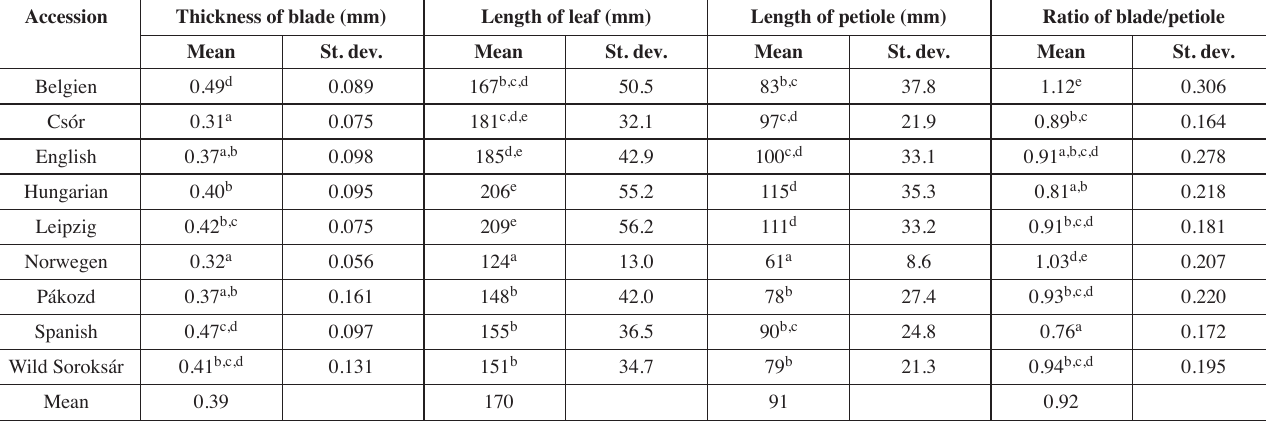
Tab. 3: Leaf characteristics of nine wormwood accessions